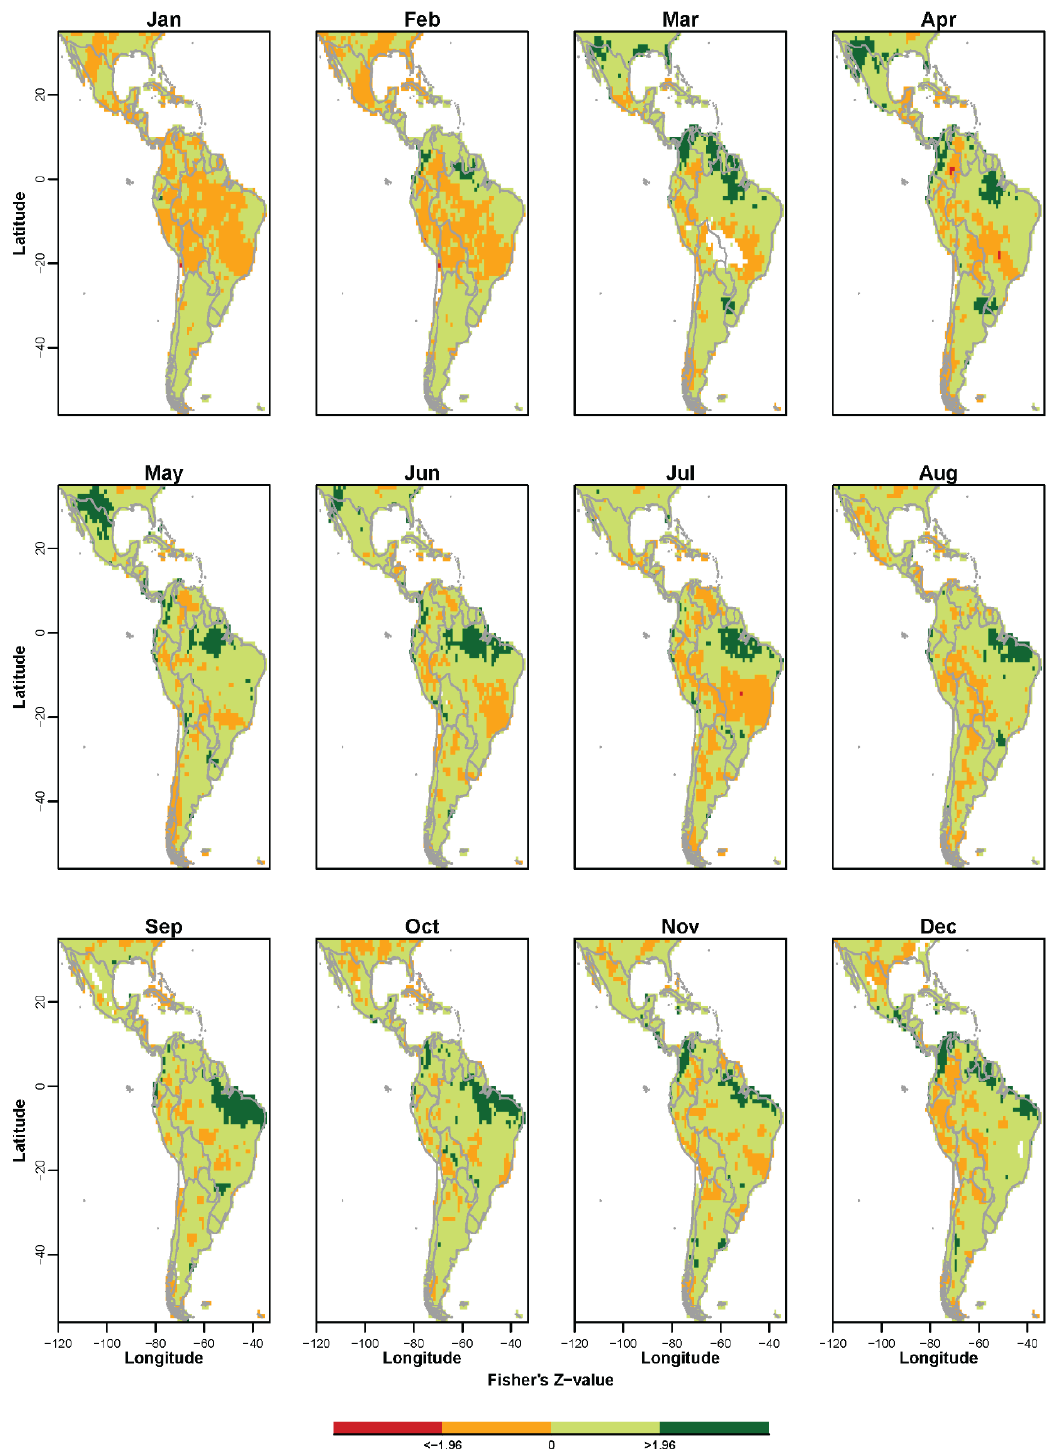
Figure A2. Monthly difference in forecast skill (Pearson correlation) between the forecast SPI6 at 6-month lead time (using the mean of the ensemble) and climatological SPI for the hindcast period (1981–2010). Values are indicated in the color bar: 1.96 is the statistical significant at the 5% significance level.